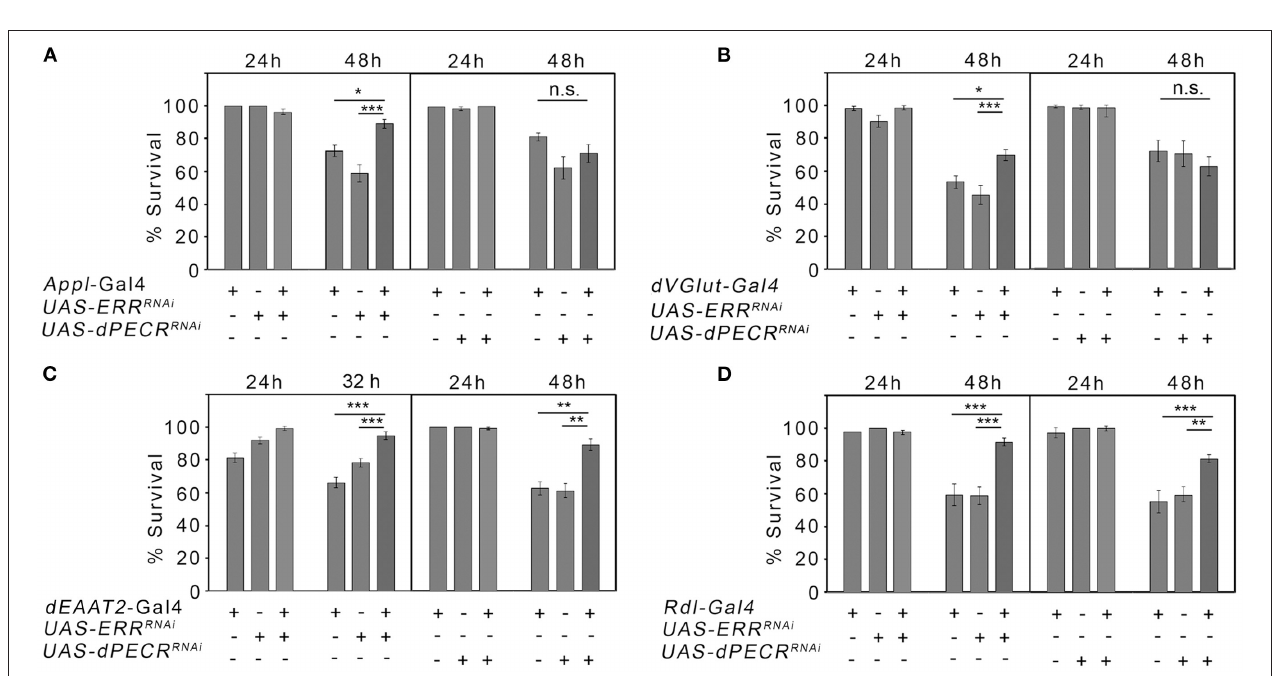
FIGURE 3 | Neuroprotection against oxidative stress due to the loss of ERR and dPECR. (A–D) Neuron-type-specific knockdown of ERR and dPECR under the control of different Gal4 drivers revealed significant differences in stress resistance against the oxidative stress of the controls and the experimental groups. N = 16–33 groups of 10 flies. The data are the means ± s.e.m. Significance was determined using one-way analysis of variance followed by post hoc Tukey-Kramer adjustment. P < 0.05, ** P < 0.01, and *** P <